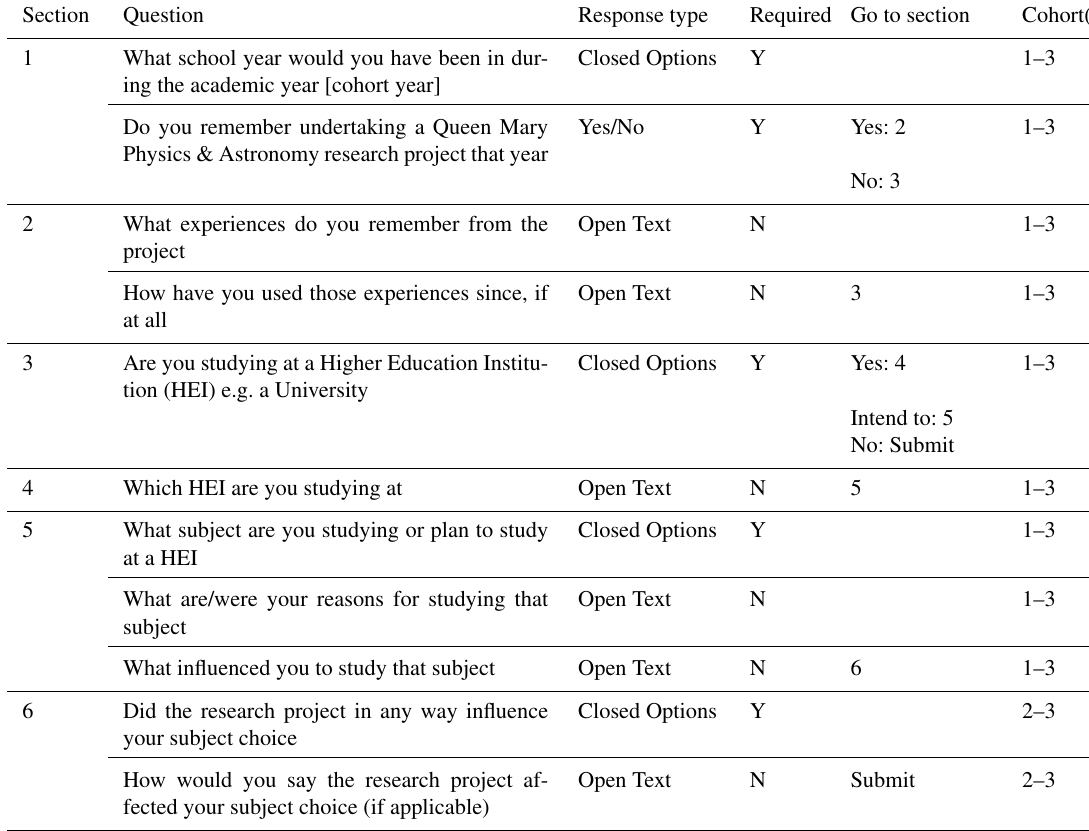
Table B1. The following questions were asked of students in the 3-year stage evaluation via an online